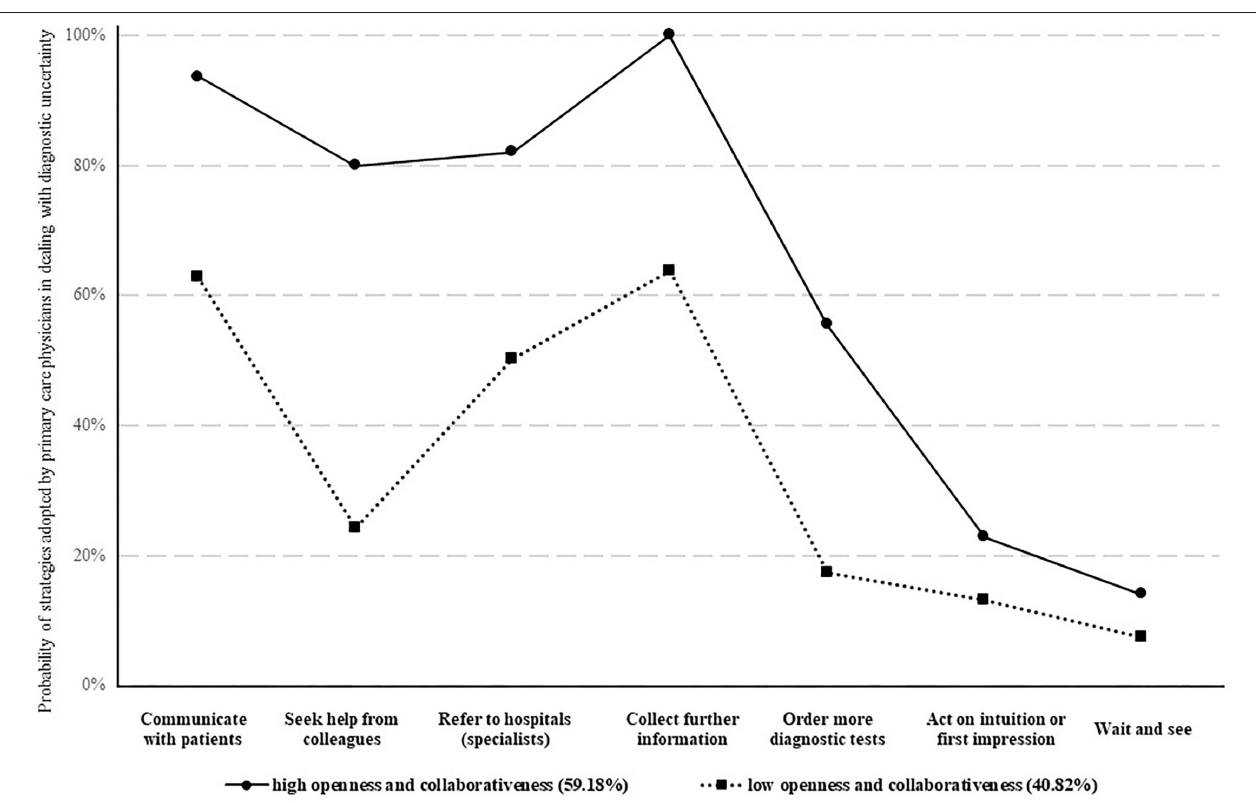
FIGURE 2 | Behavioral patterns of primary care physicians in dealing with diagnostic uncertainty. Two different behavioral patterns of physicians’ coping strategies of diagnostic uncertainty were identified. Whether a physician adopted a high or a low openness and collaborativeness to cope with diagnostic uncertainty was classified based on to what likelihood the physician would use the seven approaches to deal with diagnostic uncertainty (presented as different lines). The likelihood of adopting different approaches in coping with diagnostic uncertainty were shown in